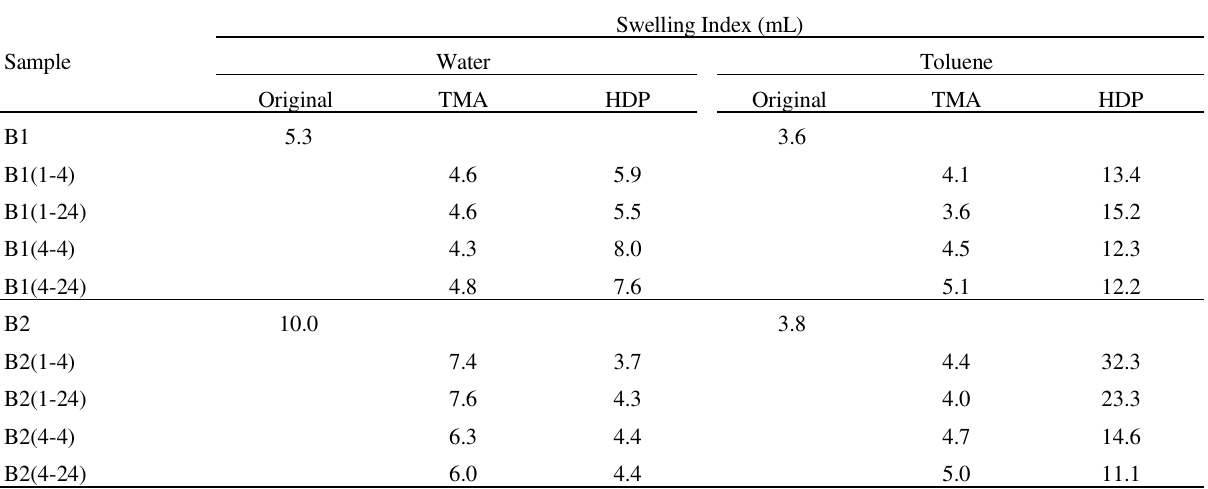
Table 1. Swelling Index (SI) of the original montmorillonites and TMA-, HDP-montmorillonites in water and in toluene